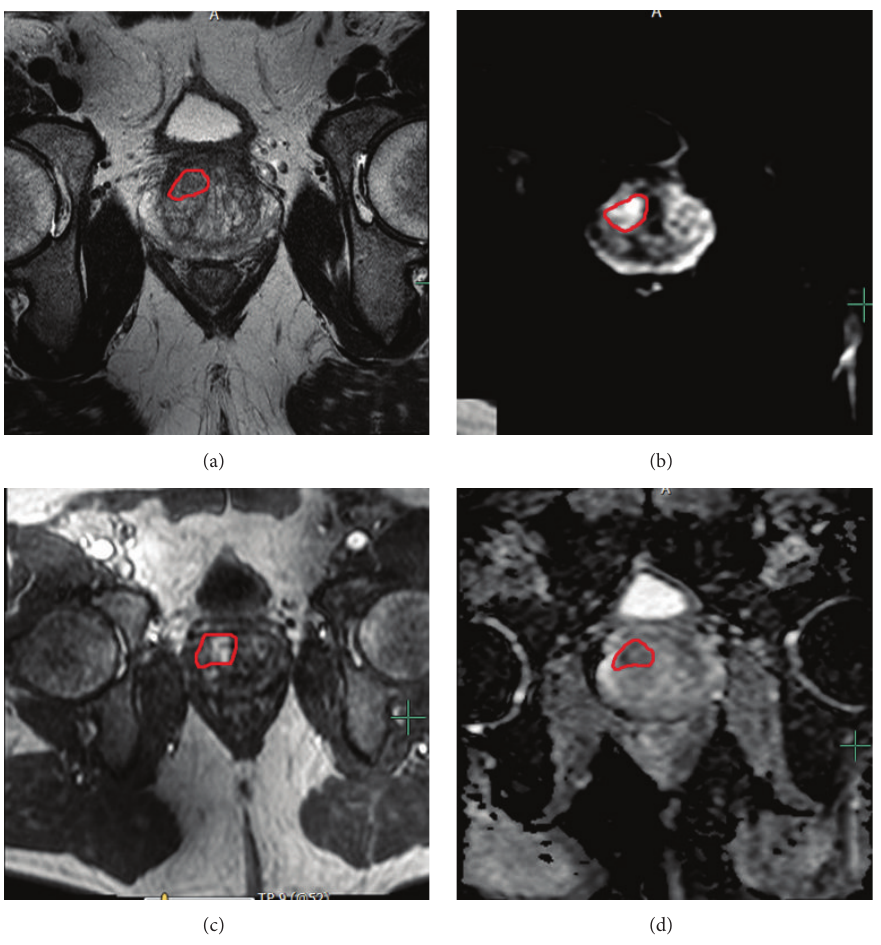
Figure 1: Multiparametric MRI evaluation and MRI-TRUS fusion biopsy in patient with multifocal intraprostatic lesions. The index lesions based upon MRI were identified in the right mid anterior central gland as an area of (a) T2 hypointensity, (b) increased signal on high 𝑏 -value DW-MRI, (c) early enhancement on DCE-MRI, and (d) diffusion restriction on ADC map of DW-MRI. The right mid anterior central gland lesion demonstrated Gleason 3 + 4 disease on fusion biopsy. A second right base posterior peripheral zone lesion demonstrated Gleason 3 + 3 disease.